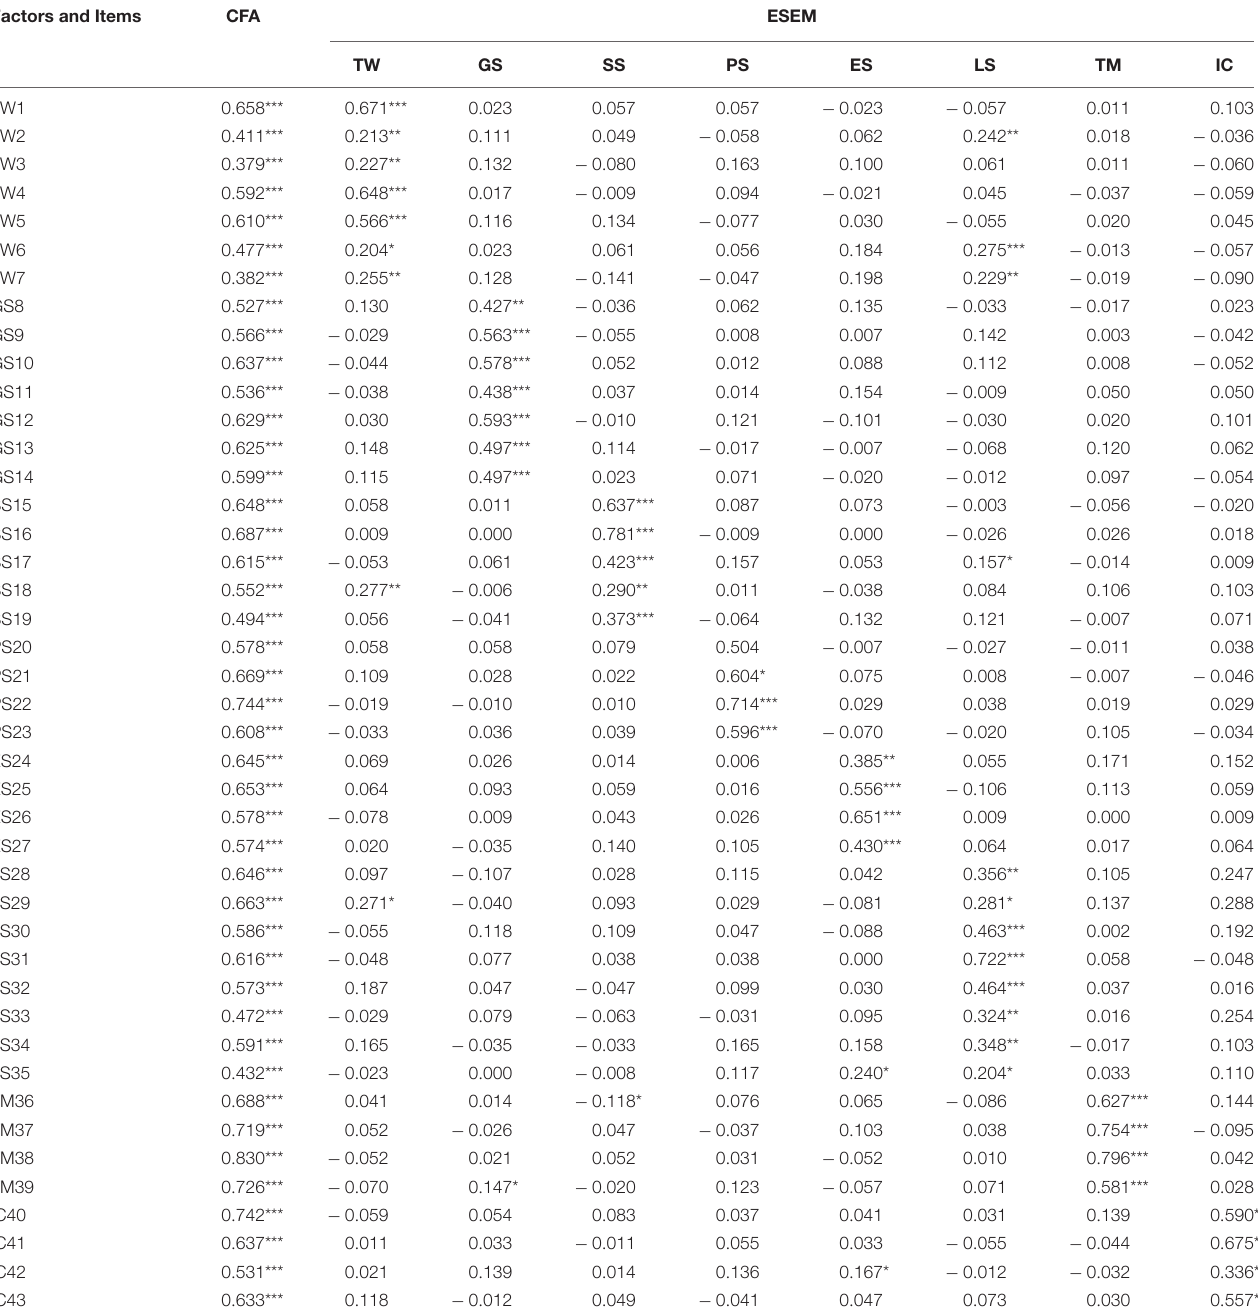
TABLE 4 | Standardized factor loadings for the life skills scale for sport. Factors and